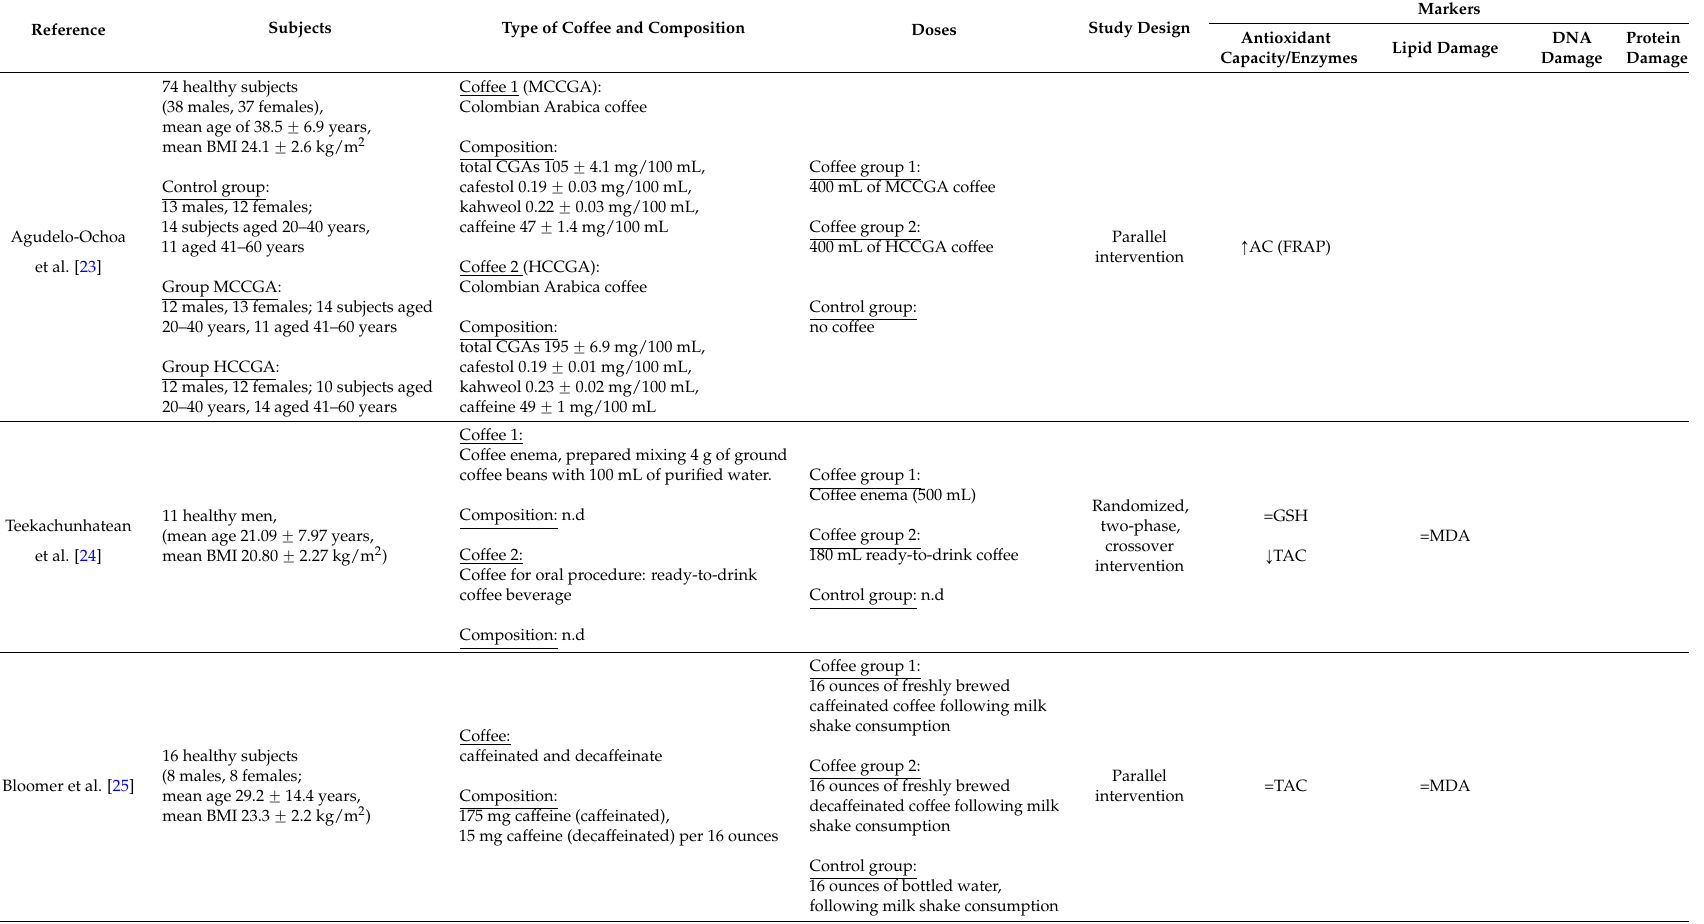
Table 1. Role of coffee in the modulation of oxidative stress biomarkers: overview of the acute human intervention studies. Reference Subjects Type of Coffee and Composition Doses Study Design